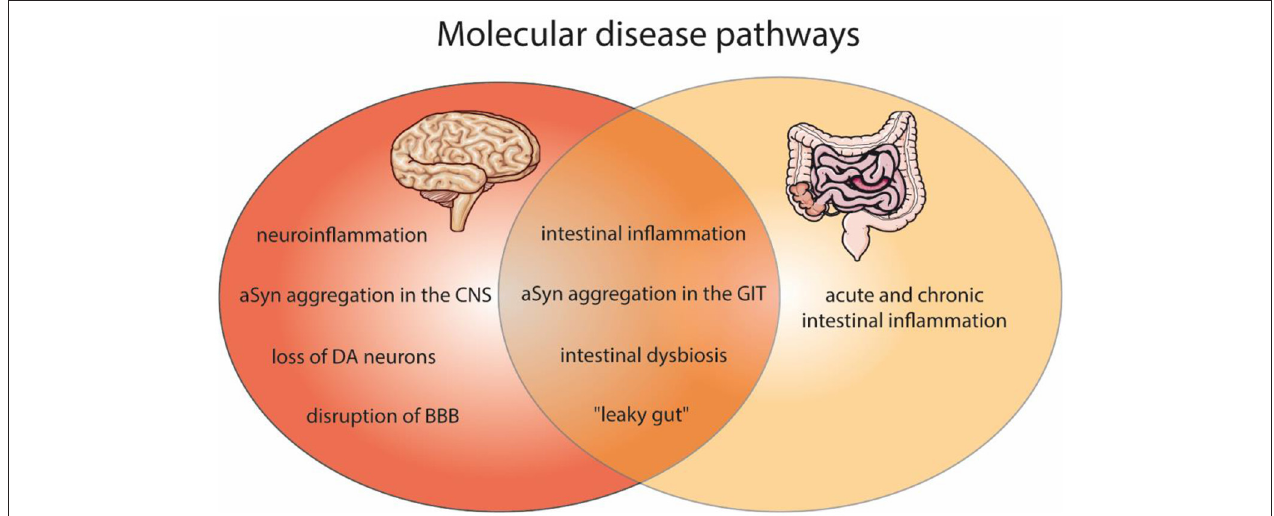
FIGURE 1 | Shared molecular disease pathways of the brain and gut pathologies, as found in PD and IBD. Affected molecular features within PD (red) and gut inflammation (light orange) as well as in both disease (dark orange). Molecular pathways of PD include neuroinflammation, aSyn aggregation in the central nervous system (CNS), dopaminergic neurons (DA) degeneration, and the disruption of blood-brain barrier (BBB). In IBD an acute and chronic intestinal inflammation is described. Both diseases can comprise intestinal inflammation, aSyn aggregation in the gastrointestinal tract (GIT), intestinal dysbiosis and a “leaky gut.” The figure contains modified components of Servier Medical Art, licensed under the Creative Commons Attribution 3.0 Unported License (CC BY 3.0)